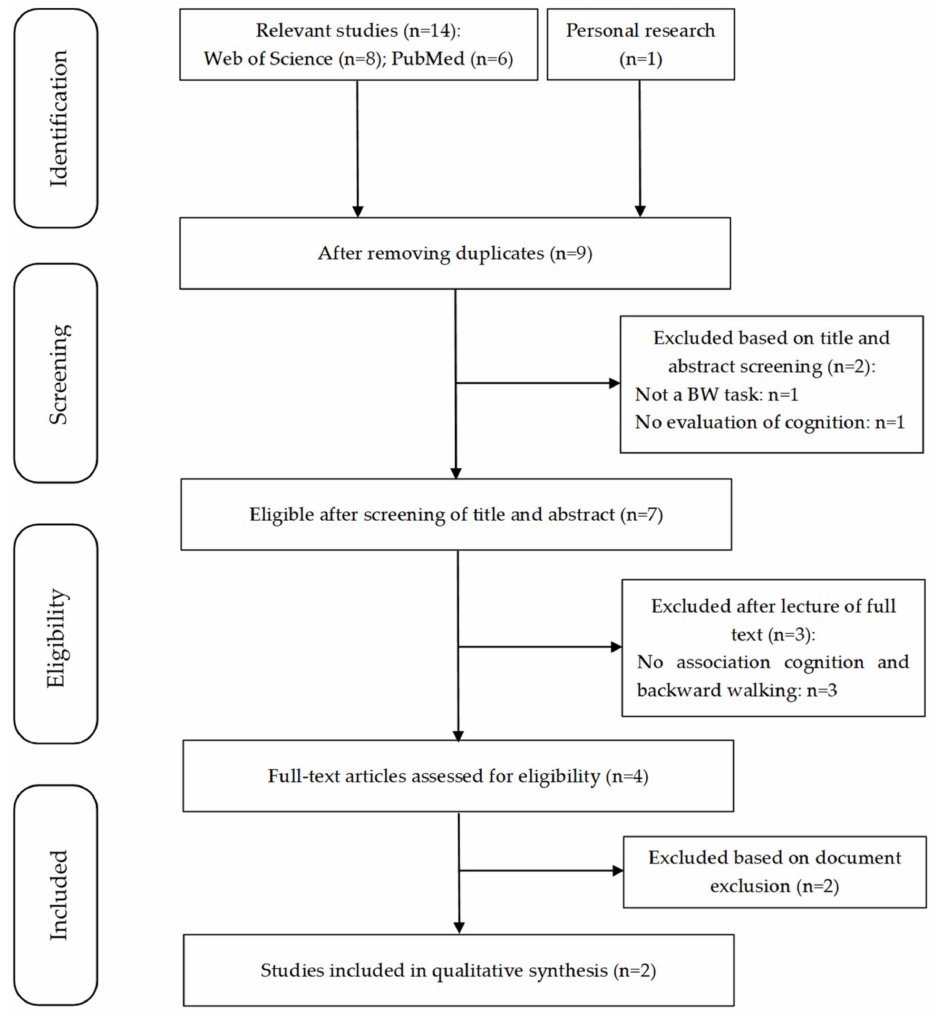
Figure 1. Flowchart of study selection. A total of two studies were included according to eligible criteria (n = number of studies, BW = backward